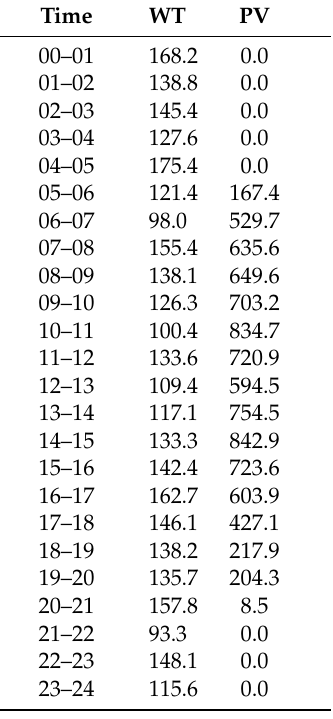
Table A1. Load and renewable generators (kW). WT: wind turbine, PV: